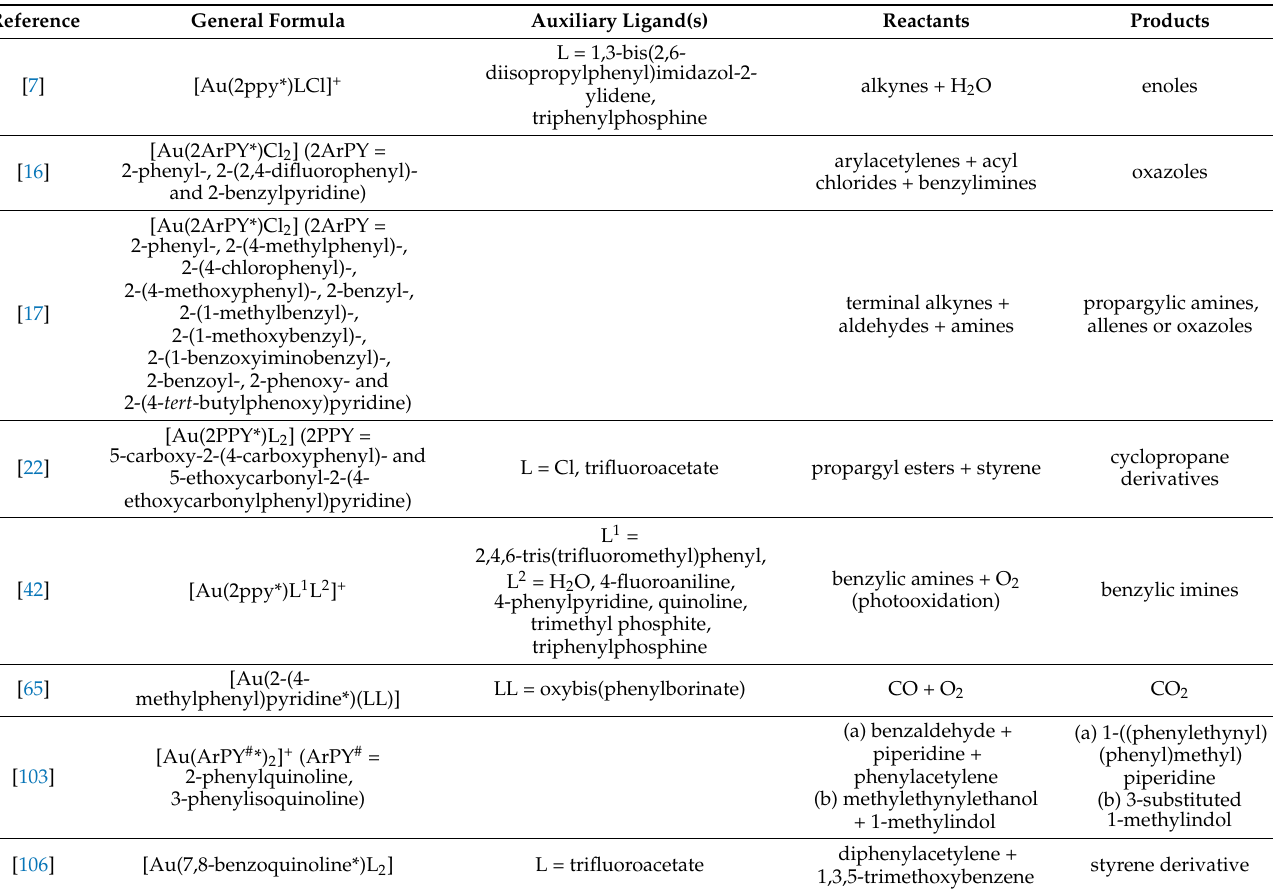
Table 11. Summary of catalytic activity studies for the reviewed Au(III)